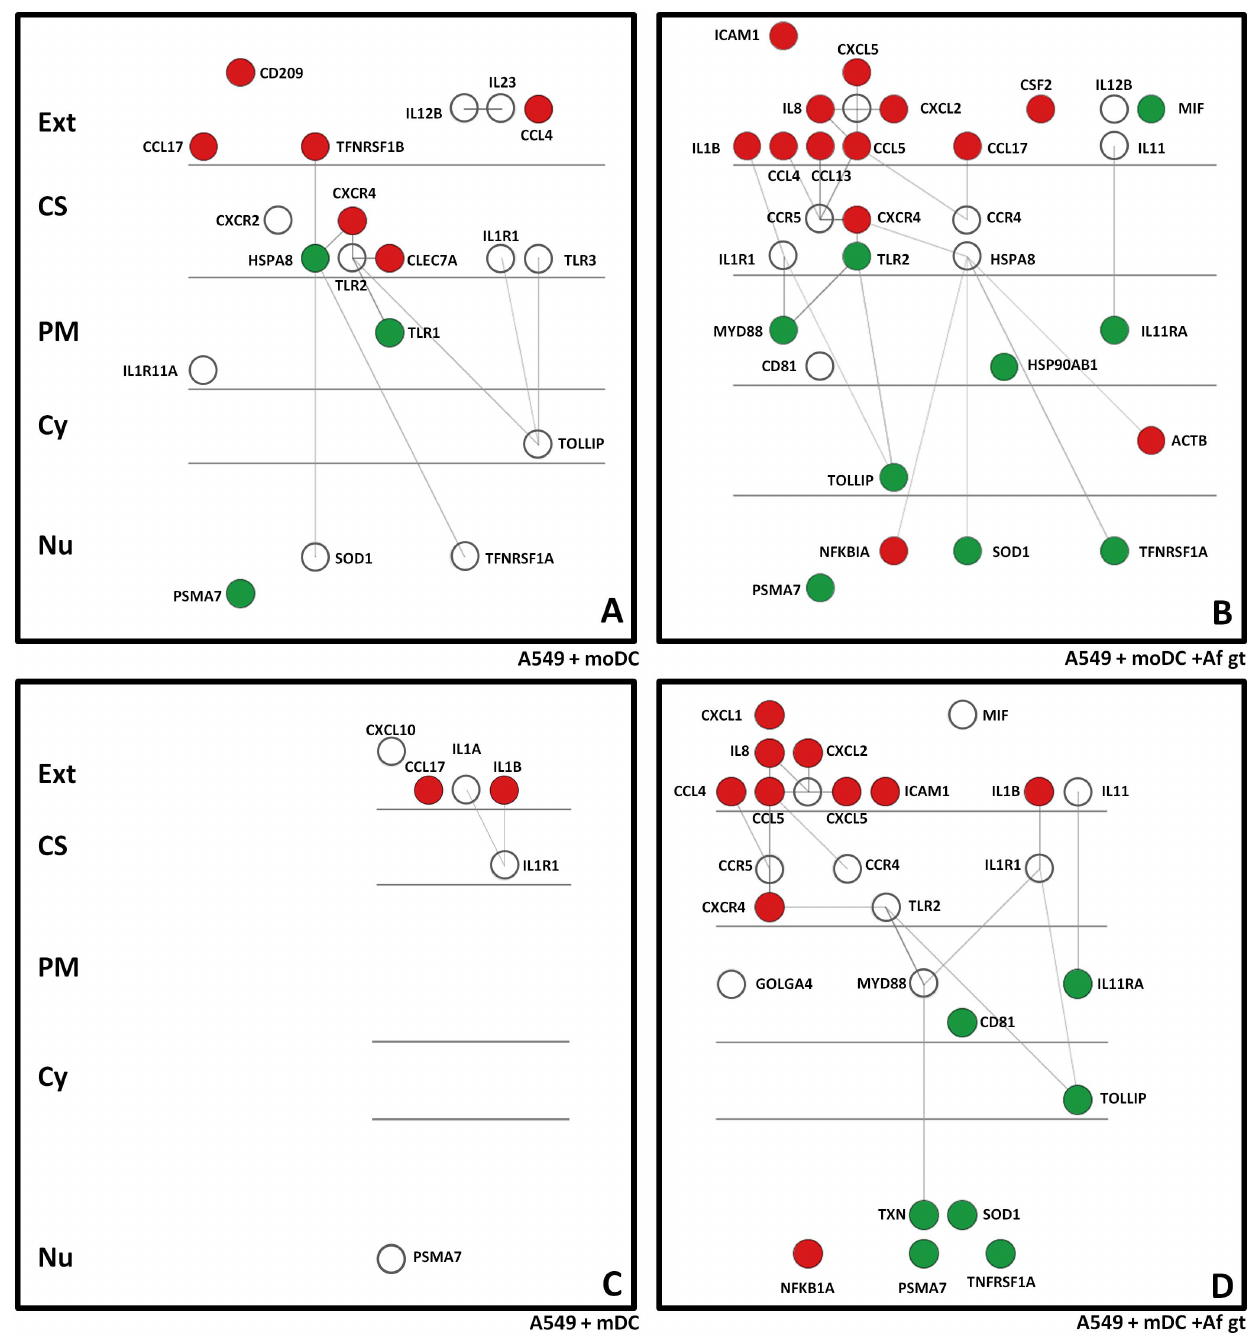
Figure 3. Gene network analyses of the expression data. Interaction networks identified when: (A) moDCs were added to the A549 cell layer. (B) moDCs and A. fumigatus germ tubes were added to the A549 layer. (C) mDCs were added to the A549 layer. (D) mDCs and A. fumigatus germ tubes were added to the A549 layer. The red circles indicate genes with an expression value . 1.0; green circles had expression values ,2 1.0; white circles had expression less than 1.0 and greater than 2 1.0. The Network analyses were conducted through the Innate DB website and were visualized in Cytoscape. The predicted physical locations of expressed genes are also indicated: extracellular (Ext), cell surface (CS), plasma membrane (PM), cytoplasm (Cy) and nucleus (Nu).